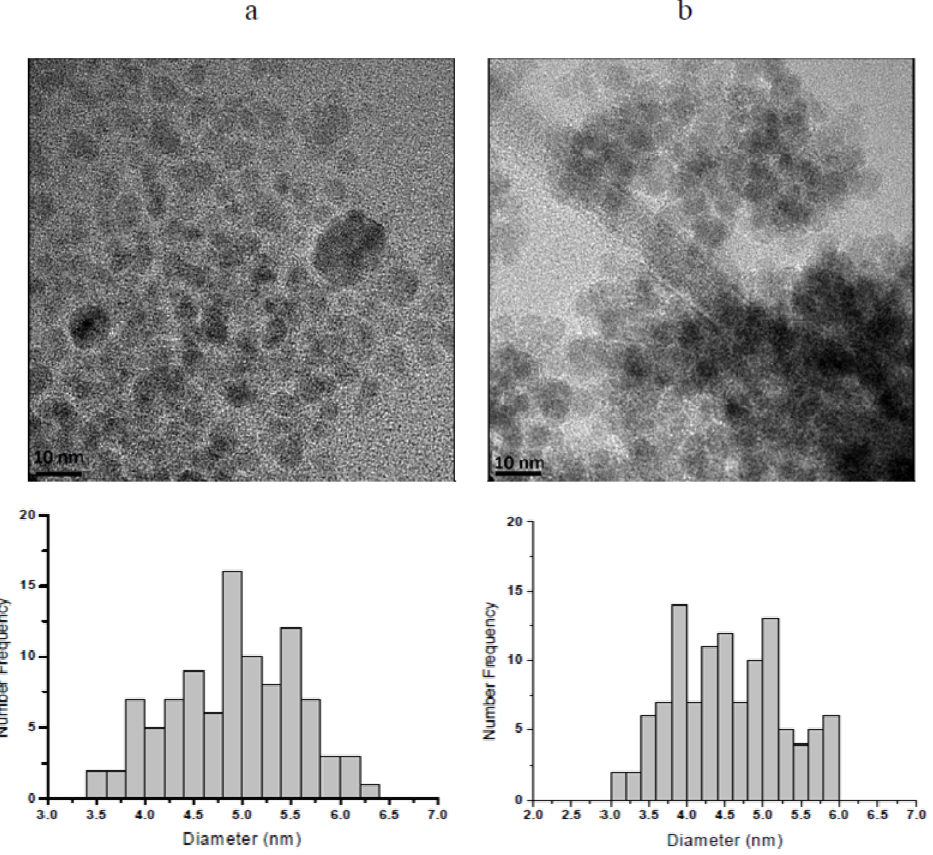
Figure 3. HRTEM micrographs of ( a ) naked magnetic nanoparticles (MH80) and ( b ) chitosan-coated magnetic nanoparticles (MHQ80). The corresponding histograms of particle sizes are also